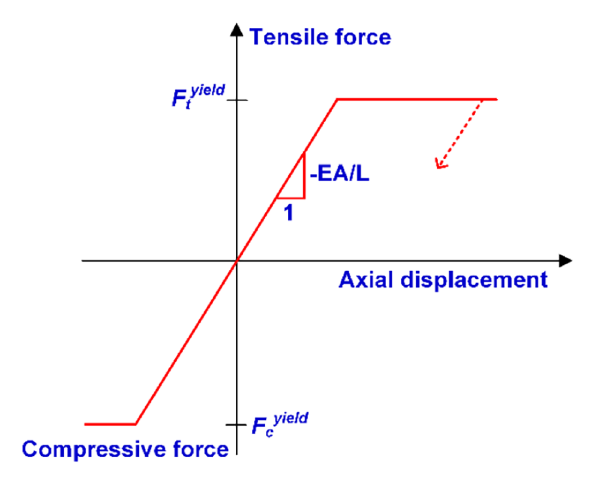
Fig. 8 Mechanical behavior of the “rockbolt” element in the axial